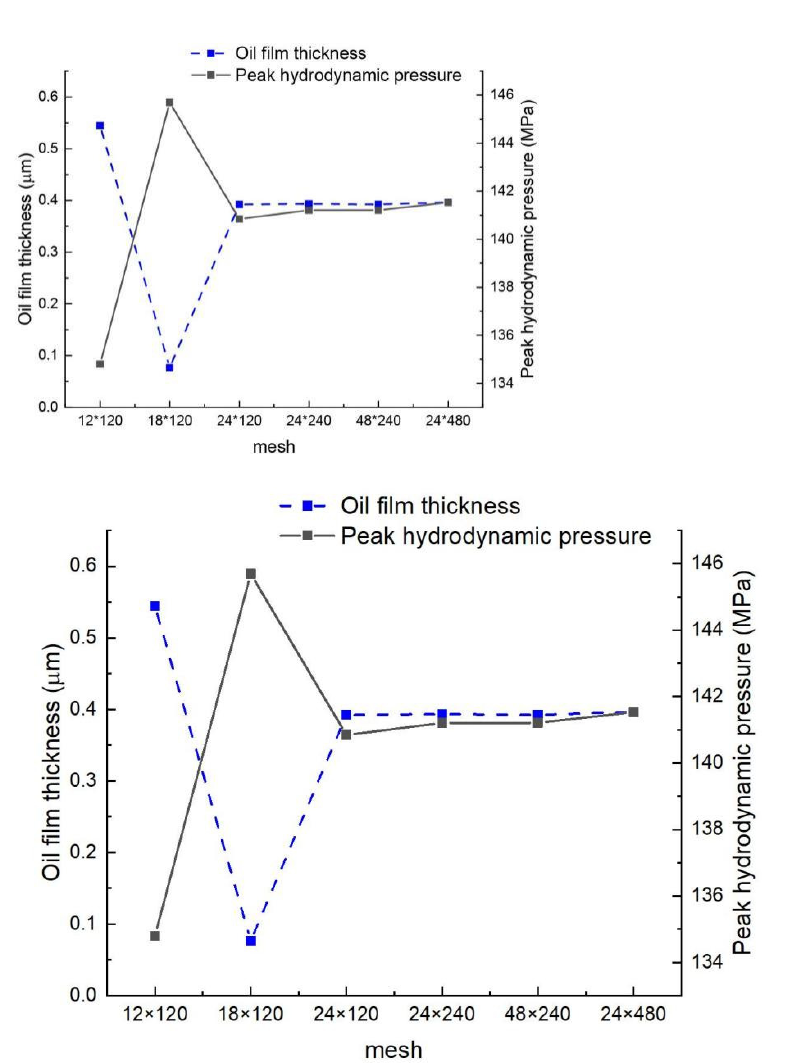
Figure 9. Mesh size independent verification.